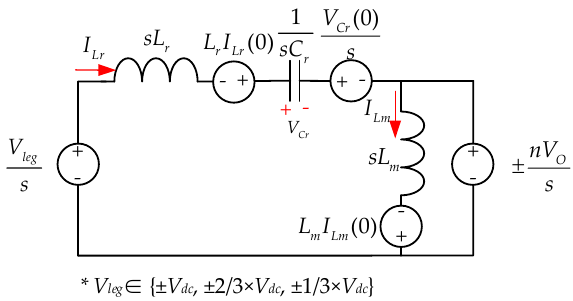
Figure 8. Equivalent circuit of the resonant tank at the resonance point.